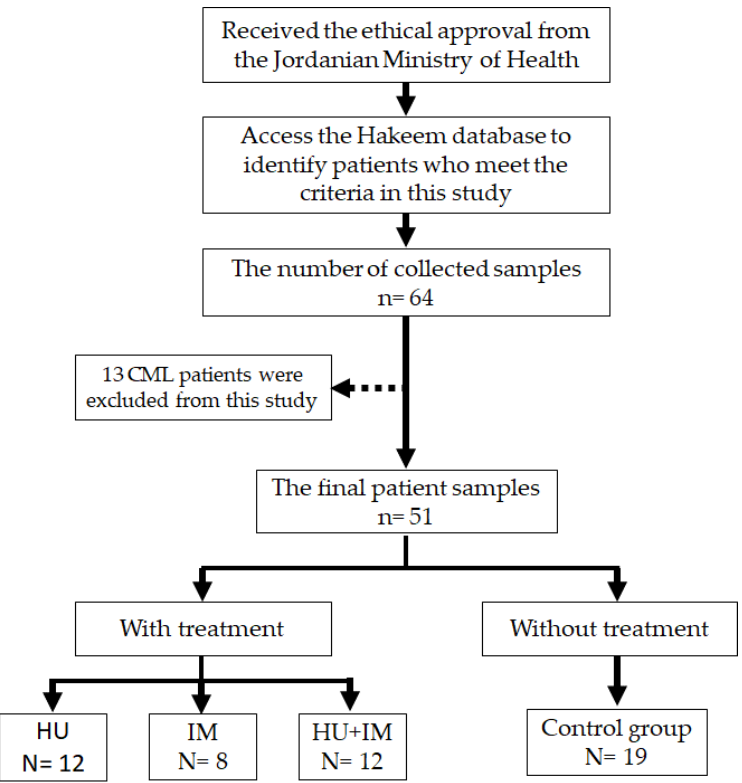
Figure 1. The flow chart illustrates our research strategy for obtaining the final sample.